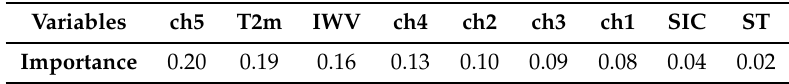
Table 4. Importance of each input variable given by the RF algorithm. Here, Channels 1–5 are denoted by “ch” plus the channel number.